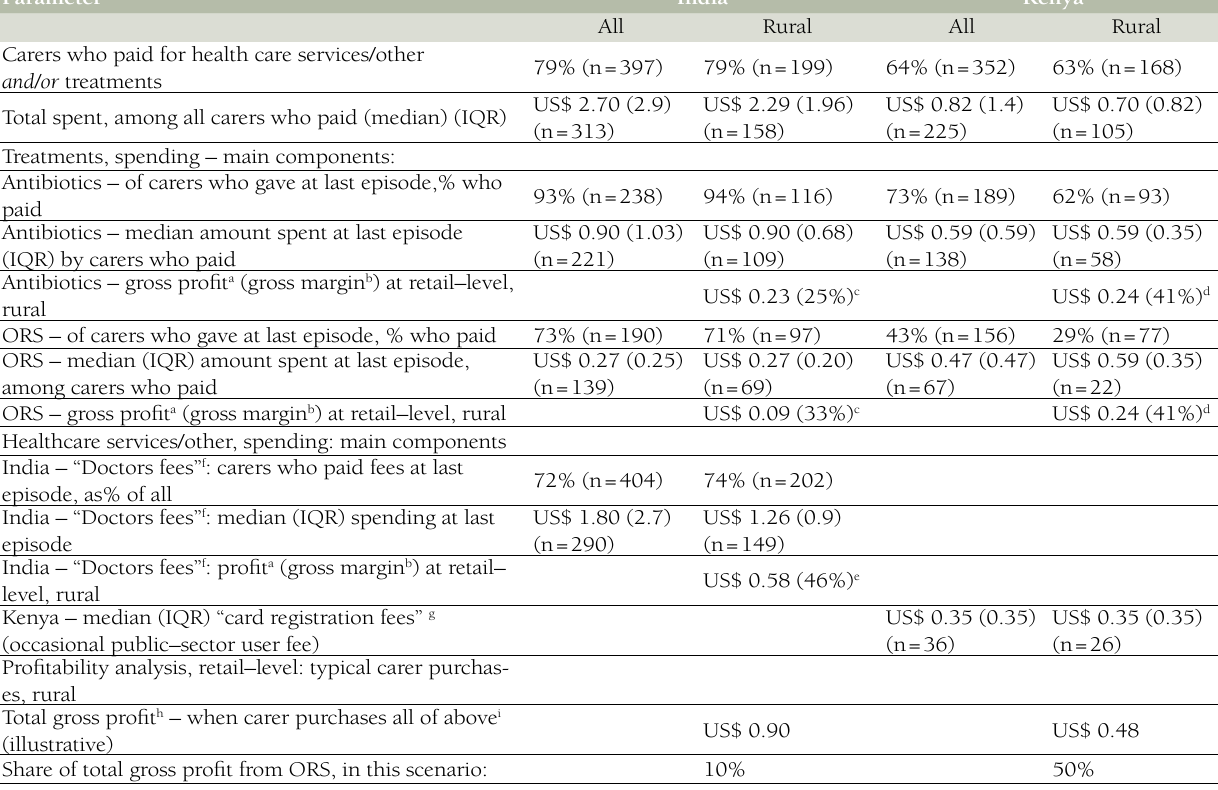
Table 7. Caregiver spending at last diarrhea episode and related profitability for rural private providers*